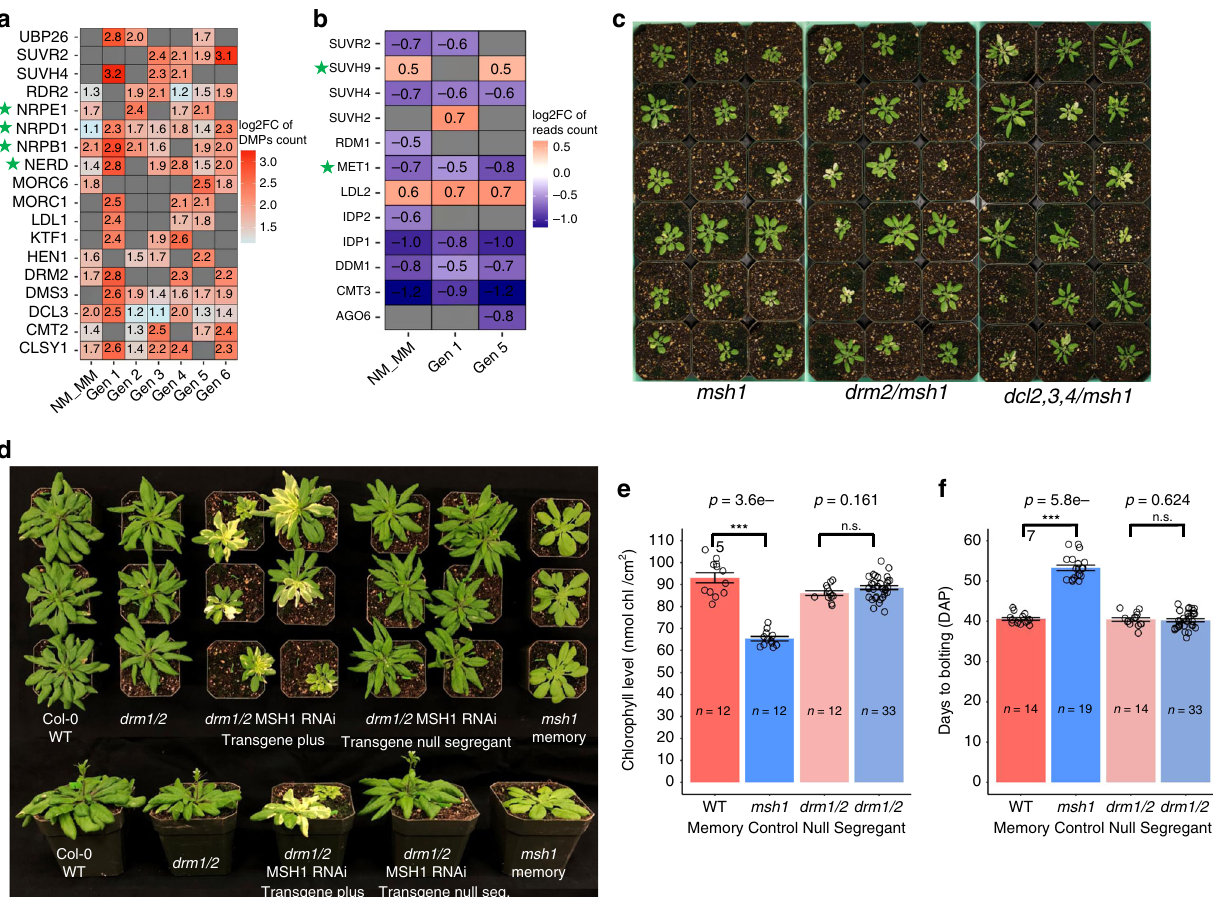
Fig. 8 Genetic control of the msh1 effect. Methylation/demethylation and silencing pathway component methylation ( a ) and expression changes ( b ) in msh1 memory. Genes associated with differentially expressed sRNA clusters were highlighted with a green star. c Double mutants of msh1 with components of the RdDM pathway. d Embryo lethality in the msh1/hda6 double mutant. Methylation/demethylation and silencing pathway component gene list was taken from Matzke et al. 5 . d Representative plants of WT, drm1/2 , drm1/2 MSH1 RNAi ( + ), drm1/2 MSH1 RNAi transgene null segregant and msh1 memory (12 h day length, 6-week-old plants). e Chlorophyll measurements, and f days to bolting in wild type (WT), msh1 memory, drm1/2 and drm1/2 MSH1 RNAi transgene null segregant. Bars represent means ± SE, n represents number of plants in each population. One-sided Mann − Whitney test was used to compute p value. Signi fi cance codes: ***( p value < 0.001), ns not signi fi cant. Plants grown on normal soil conditions. Chlorophyll level was measured with a SPAD-502 meter 4 weeks after planting. Source data underlying Fig. 8e, f are provided as a Source Data fi